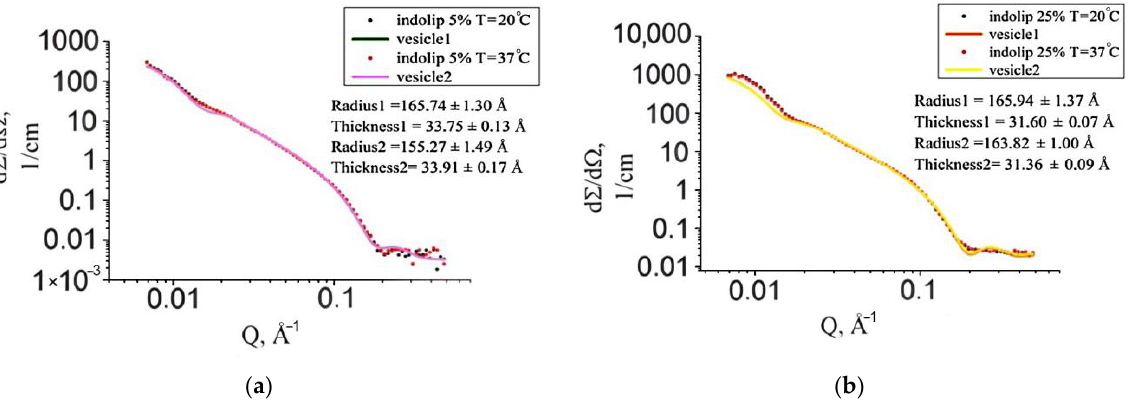
Figure 6. Experimental curve of small-angle neutron scattering of samples with Indolip concentra- tion of 5% ( a ) and 25% ( b ) at 20 °C and 37 °C and their approximation functions that describe vesi- cles.